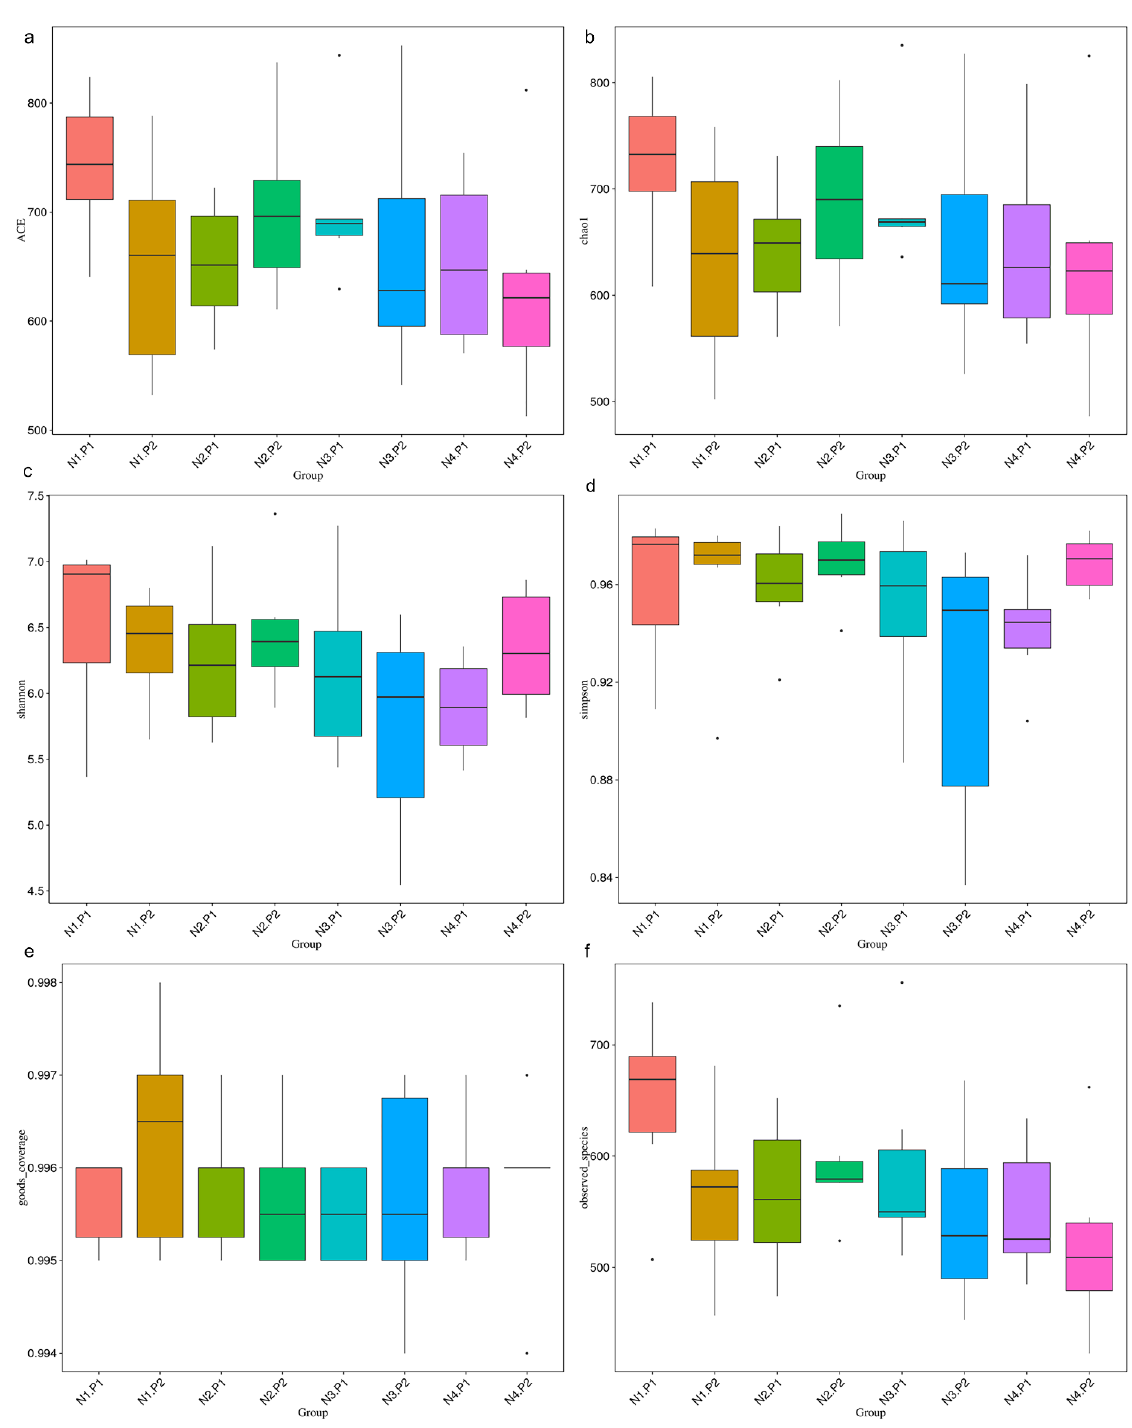
Figure 1. Alpha diversity index analysis. ( a ), ACE index; ( b ), chao1 index; ( c ), Shannon index; ( d ), Simpson; ( e ), goods_coverage index; ( f ), observed_species. P1: the experimental period is 7 days. P2: the experimental period is 14 days. N1: 22.5 mg/kg niacin group. N2: 30 mg/kg niacin group. N3: 45 mg/kg niacin group. N4: 75 mg/kg niacin group. Black dots: abnormal